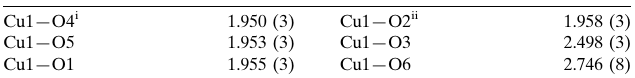
Selected bond lengths (A˚ ).